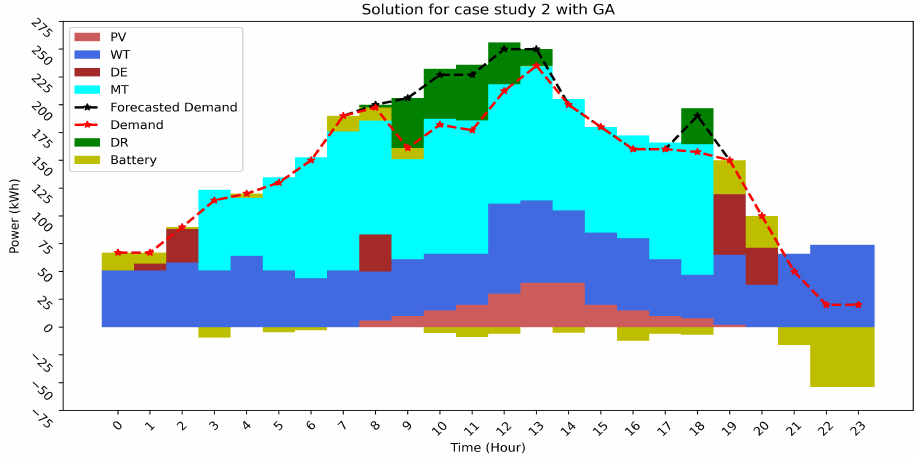
Figure 11. UC uses BESS and DR-based GA approach.